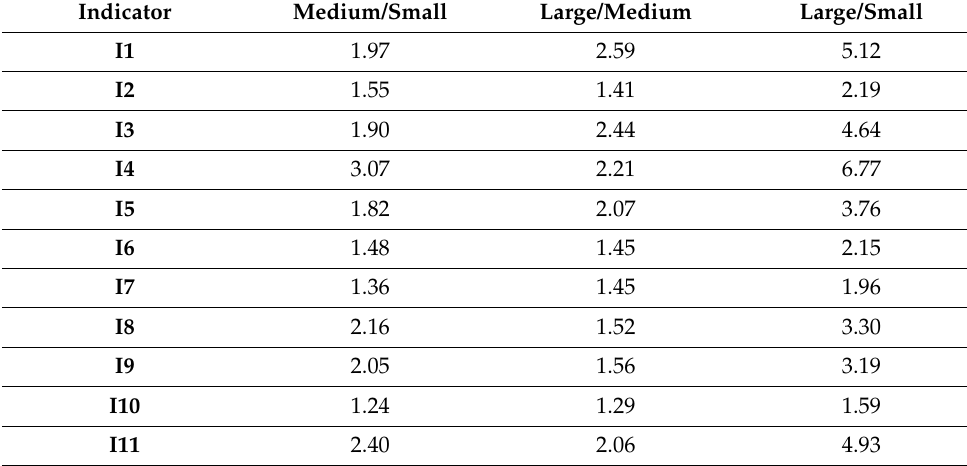
Table 7. Ratio between examined indicators in small and medium, medium and large and small and large